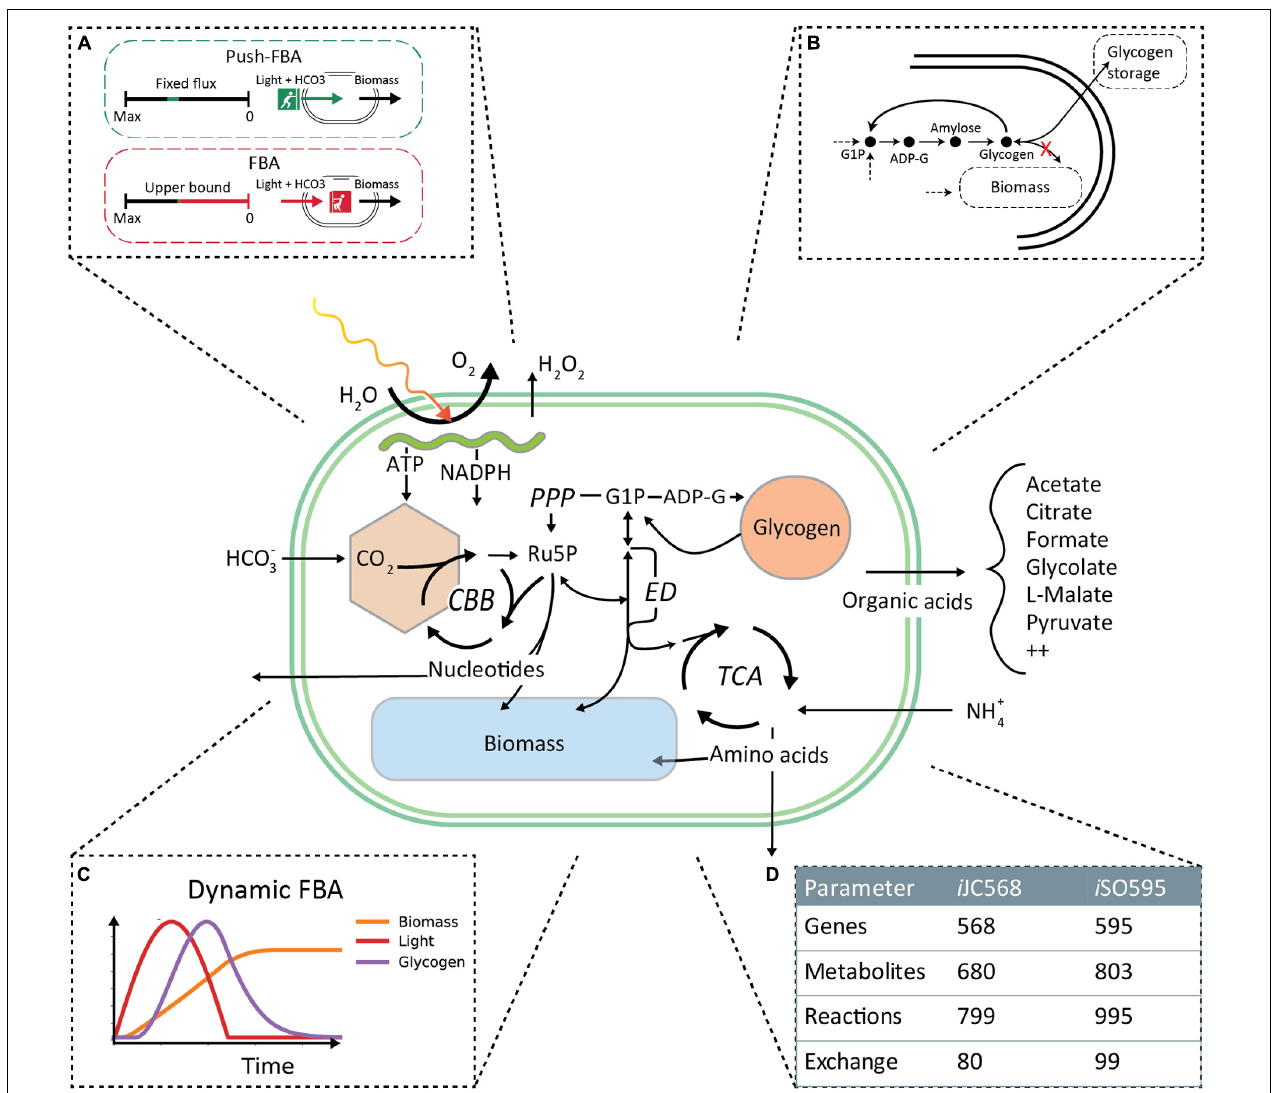
FIGURE 1 | iSO595 is an updated reconstruction of Prochlorococcus marinus MED4, featuring a complete Entner–Doudoroff pathway, rewired glycogen metabolism and increased coverage of the genome. The central panel is a simplified illustration covering the most relevant metabolic features. (A) To simulate the natural environmental constraints experienced by Prochlorococcus we use “Push-FBA”: Light and bicarbonate uptake are given a fixed flux independent of growth rate. This contrasts standard FBA where light and bicarbonate would be “pulled” in by the demand needed to support maximal growth rate up to a given bound. (B) We rewired the glycogen metabolism in i SO595 to study the dynamic allocation the dynamic allocation of glycogen. (C) Additionally, we implemented dynamic light conditions and light absorption in COMETS to simulate the growth of P. marinus during the diel cycle. (D) i SO595 has increased coverage both in terms of genes, reactions and metabolites compared to its ancestor i